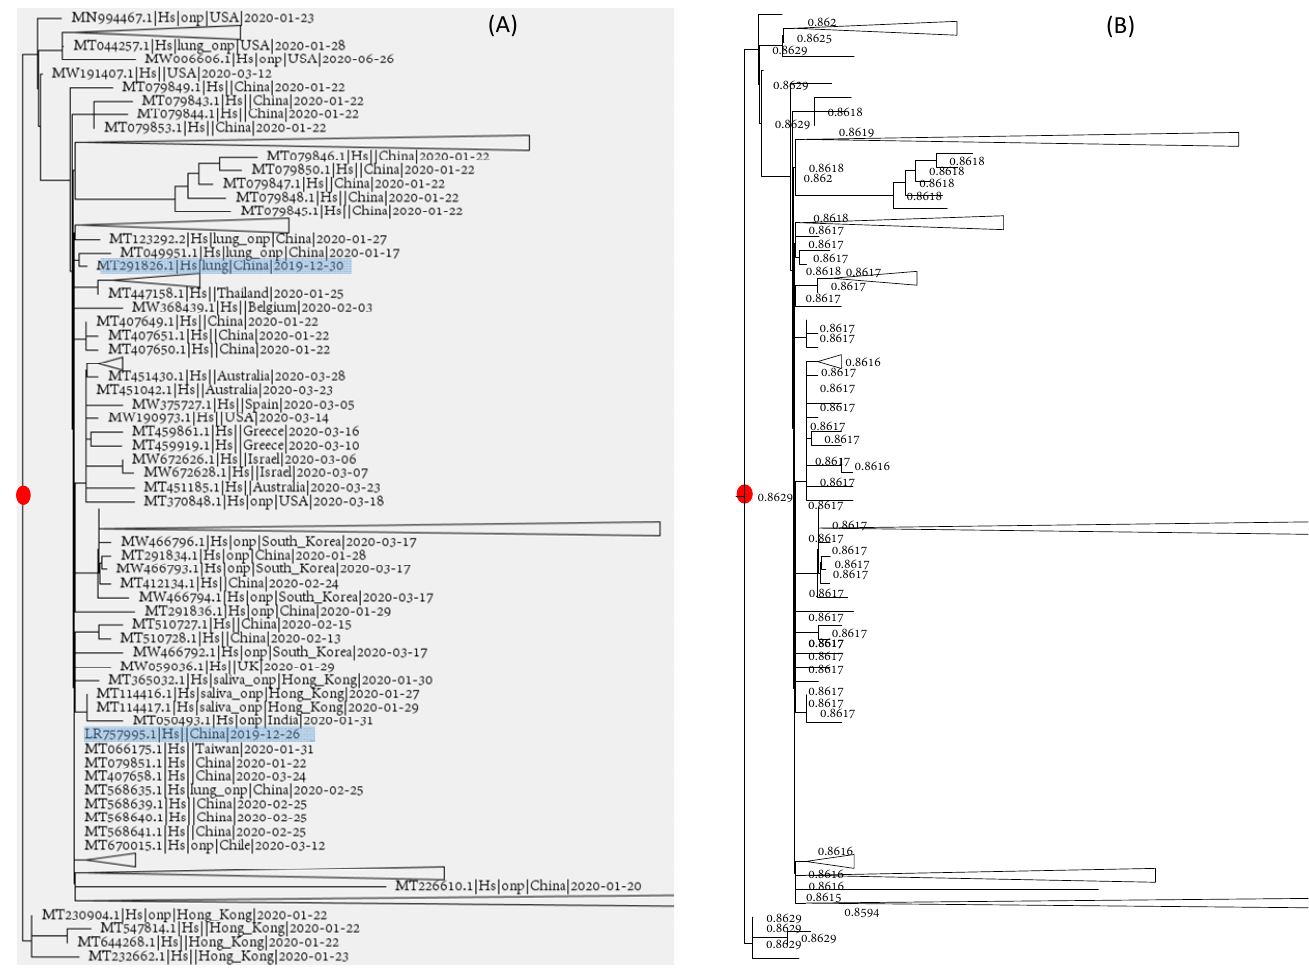
Figure 5. Root identification is hard: ( A ) the tree of 83688 SARS-CoV-2 genomes, with the root indicated by a red dot and many clades collapsed to ease visualisation of viral genomes close to the root; ( B ) the same tree with different candidate rooting positions with Pearson correlation coefficient (r) between the root-to-tip distance and collection time. The red dot indicates the rooting point with the highest r, but a number of alternative root positions have nearly identical r.